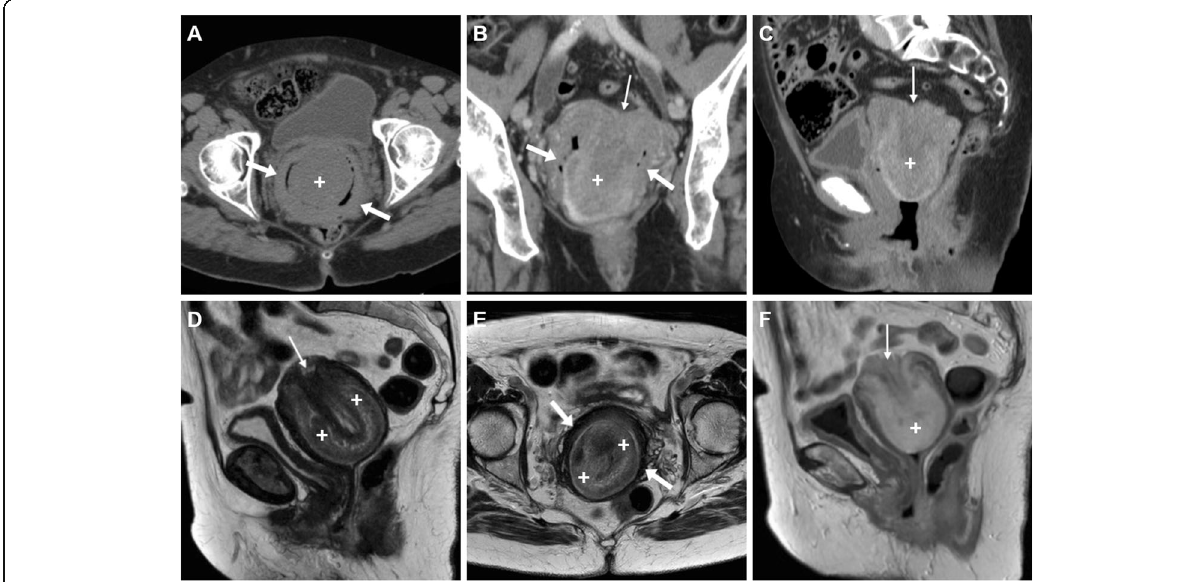
Fig. 7 Surgically confirmed, spontaneous uterine inversion without mass lesions in a 79-year-old woman experiencing muco-haemorrhagic vaginal discharge. Precontrast ( a ) and contrast-enhanced ( b , c ) CT images showed a solid, mass-like enhancing structure (plus sign) surrounded by air coursing through the dilated uterine cervix. Loss of the normally convex uterine fundus (thin arrows) was noted. Physically, the upper vagina was occupied by the inverted uterus. Sagittal ( d ) and axial ( e ) T2-weighted MRI images confirmed the diagnosis by showing lost convexity and depression of the uterine fundus (thin arrows), U-shaped inverted uterus (plus sign) with preserved zonal anatomy for age and normal homogeneous enhancement on post-gadolinium T1-weighted image ( f ), which coursed downwards through the hypointense uterine